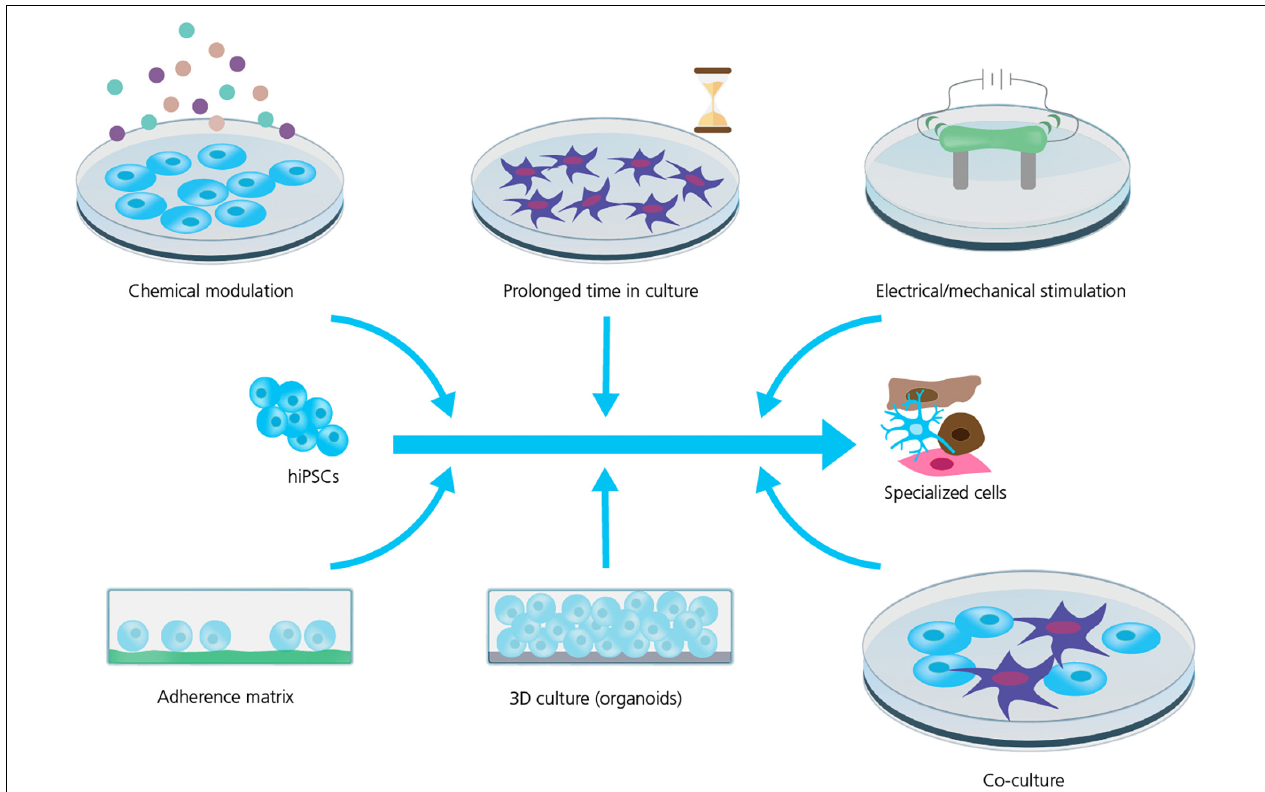
FIGURE 2 | Strategies for improving hiPSC maturity. Several strategies are used to improve the maturity and phenotype specificity of hiPSC-derived cell lines. However, the mechanism and efficiency of these strategies are still being explored and requires rigorous characterization and quality control. Adapted from Ahmed et al. (2020), with permission under Creative Commons Attribution License (CC